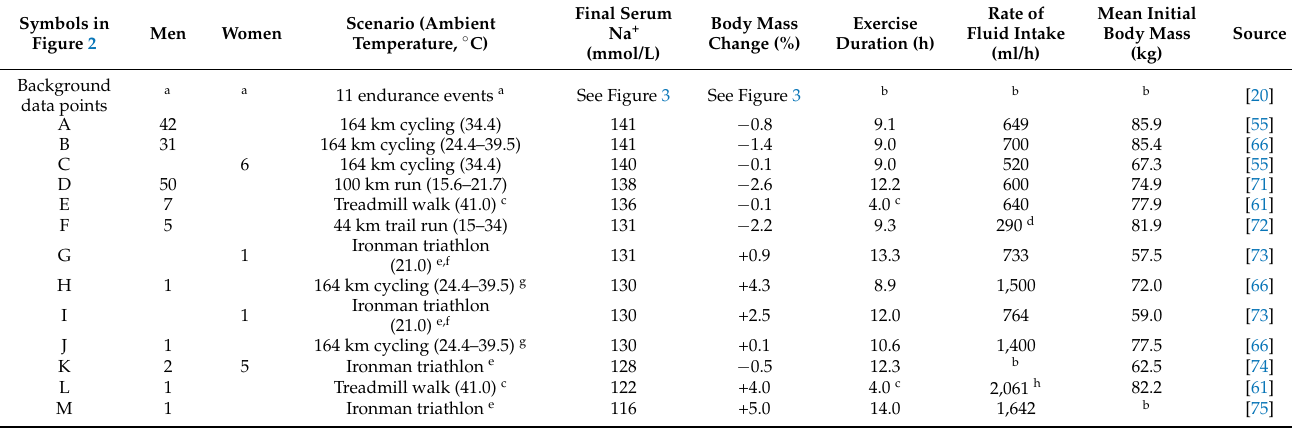
Table 4. Factors that influence exertional hyponatremia. Letters in column 1 refer to the symbols embedded in Figure 2. Symbols in Figure 2 Background data